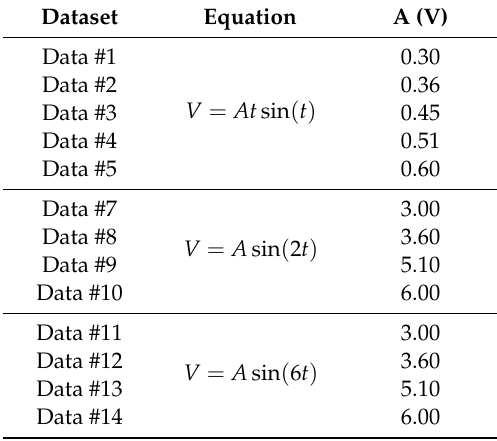
Table 1. Input voltages.